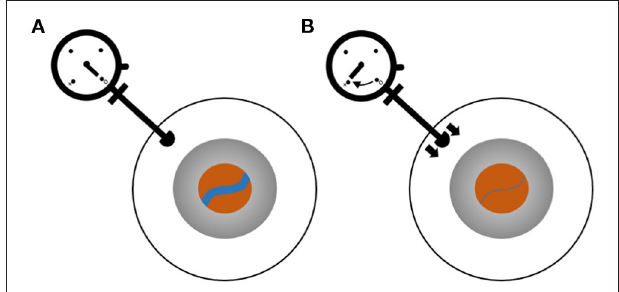
FIGURE 1 | Ophthalmodynamometry for measurement of retinal venous pressure. Ophthalmodynamometer device consists of a probe with which pressure can be applied to the sclera and a dial indicating the pressure. The eye is shown schematically as three circles representing the sclera (white), iris (gray), and retina visualized through the pupil (orange). The blue line is a retinal vein. (A) Baseline, no force being applied to the eye. (B) Pressure is applied by pushing the ophthalmometer against the sclera, and the vein diameter is observed to decrease. The pressure at which the vein collapses is recorded.